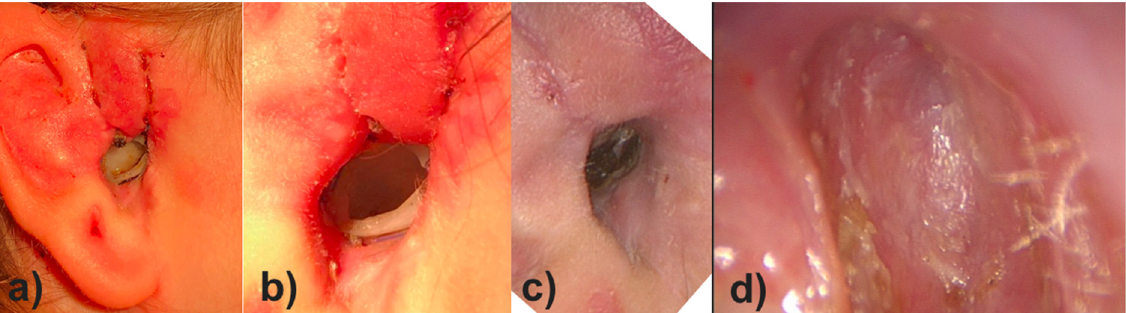
Figure 9. Postoperative images of the EEC of the patient during the follow up visits. ( a ) Averview of the auricle and EEC with the implant in situ two weeks postoperatively; ( b ) close-up of the EEC with the well adapted implant in situ three months postoperatively right before explantation; ( c ) the EEC four weeks after explantation of the implant (i.e., four months after implantation) without clinical signs of inflammation; ( d ) close-up of the EEC one year after surgery: the EEC shows a good patency and view on the TM after total reconstruction of the TM with Tutoplast ® Fascia lata and perichondrium.